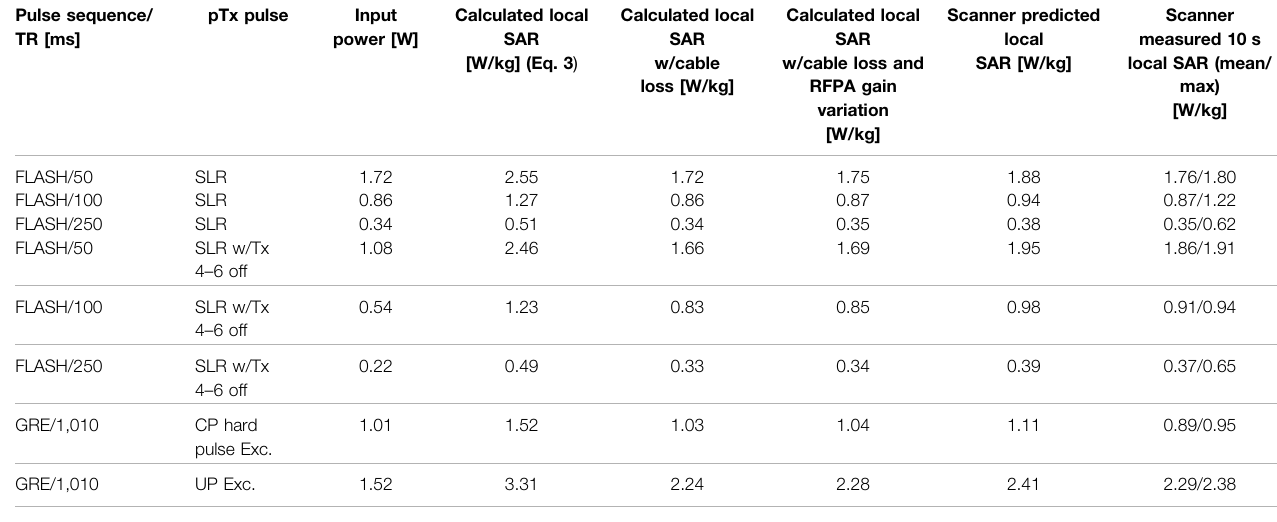
TABLE 1 | Time-averaged input power (W) and SAR values (W/kg) for 4 pTx pulses: SLR, SLR w/Tx 4-6 off, CP hard excitation, and UP Excitation. For calculation and experimental measurements, each pTx pulse is associated with a speci fi c sequence and TR. Column 4 values are from Eq. 3 using the external pulses in volts and the electromagnetic fi eld simulation VOPs.Column 5values add thecableloss from theRF power ampli fi er (RFPA)to thecoil plug,measuredtobe 1.7 dB. Column 6 valuesare the true local SAR calculations with cable loss and RFPA gain variation included. The values in column 6 are in good agreement with the scanner predicted local SAR and measured local SAR in the fi nal two columns.